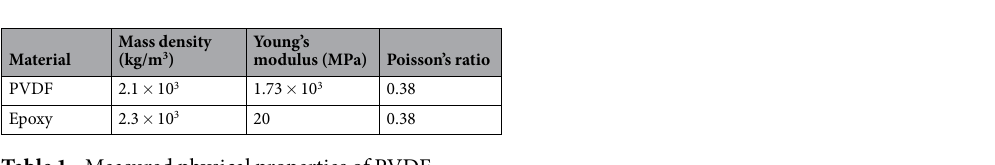
Table 1. Measured physical properties of